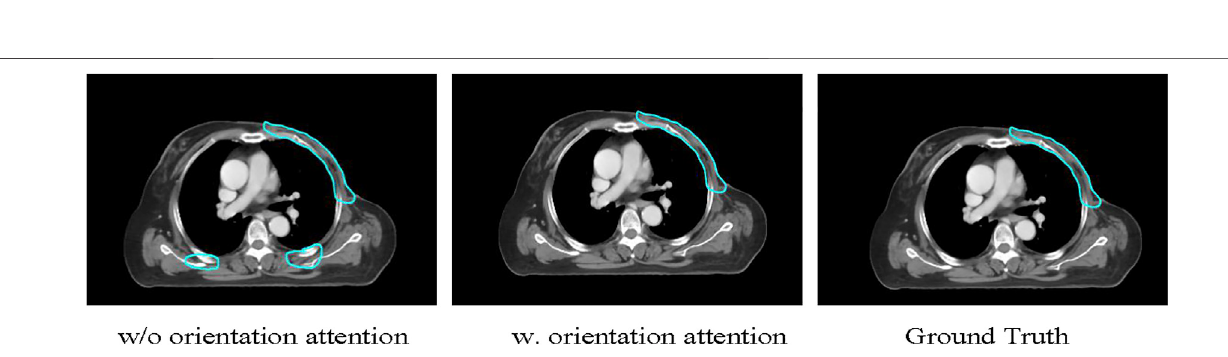
Frontiers in Physics |